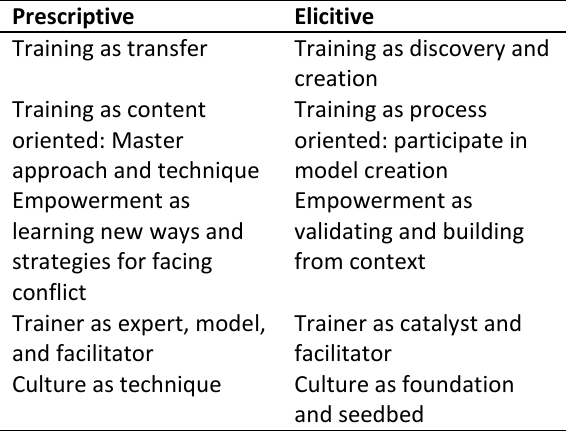
Table 1. Types of conflict transformation (Source: Le- derach, 1995, p.